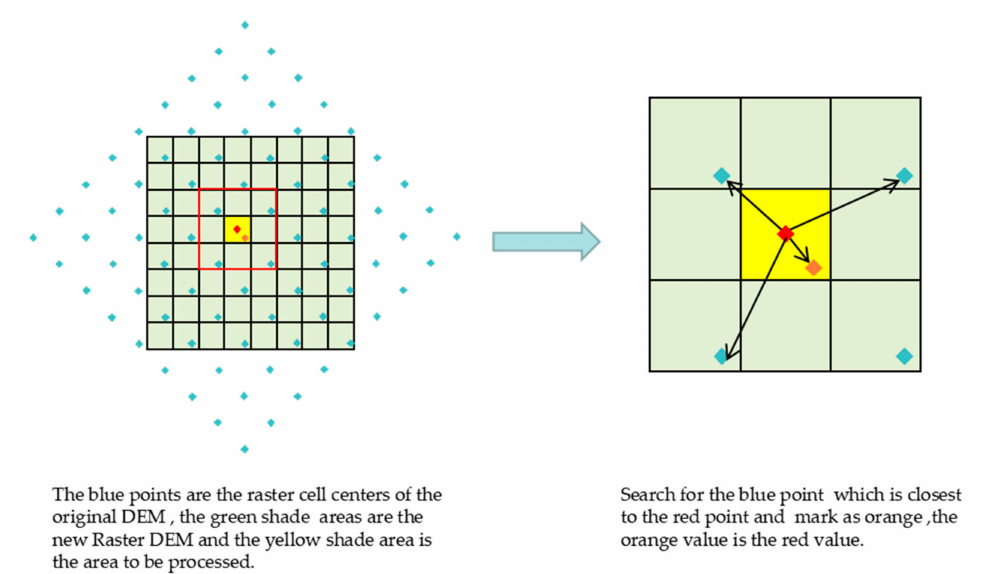
Figure 3. The resample processing of the Nearest Neighbor Interpolation Algorithm. Using the above method, the raster DEM is converted into the resampled 10 × 10 pixel-size raster